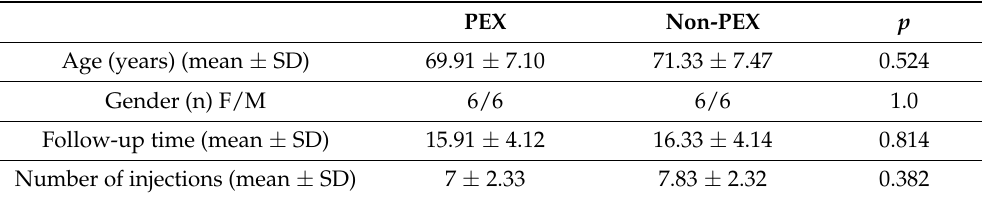
Table 1. Demographic and clinical characteristics of groups. PEX Non-PEX p Age (years) (mean ± SD)